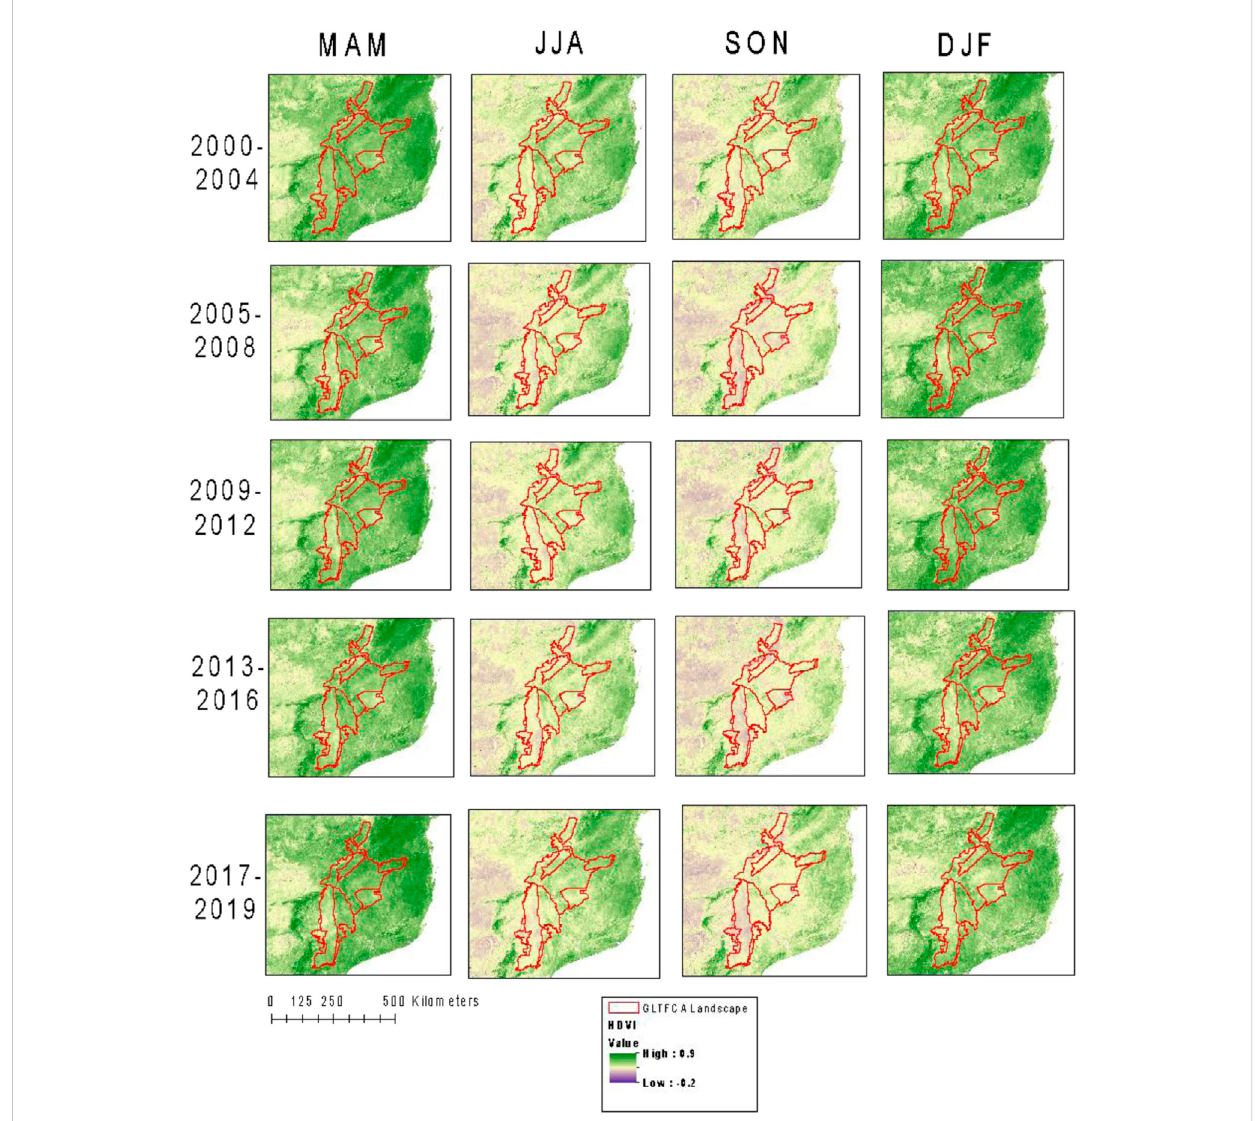
FIGURE 6 Mean Normalized Difference Vegetation Index (NDVI) across southern Africa by time period (NDVI = 2000 – 2004, 2005 – 2008, 2009 – 2012, 2013 – 2016, 2017 – 2020) and season (MAM, March, April, May; JJA, June, July, August; SON, September, October, November; DJF, December, January,